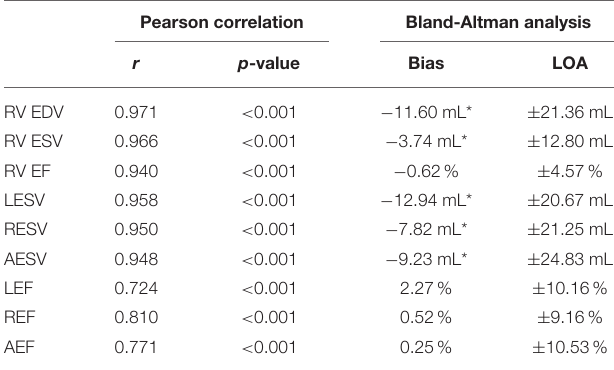
TABLE 5 | Correlation and agreement between 3D echocardiography- and cardiac magnetic resonance imaging-derived measurements. Pearson correlation Bland-Altman analysis